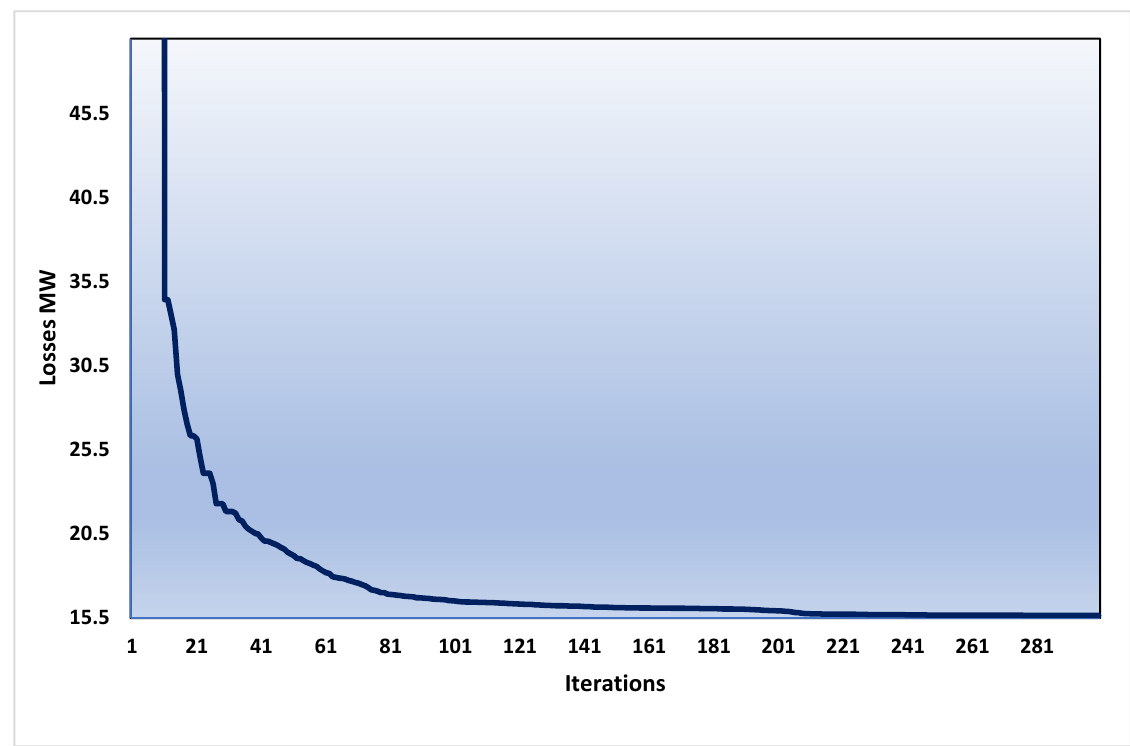
Figure 6. Convergence curves of TLBA for the minimization of the ETL S of the IEEE 57-bus network.